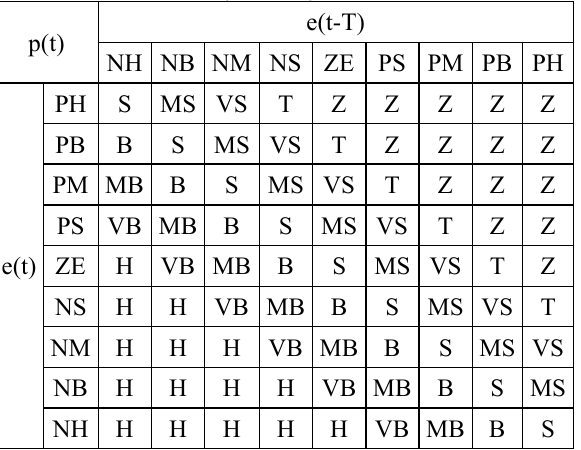
Table 7. Fuzzy rule system of FLREM